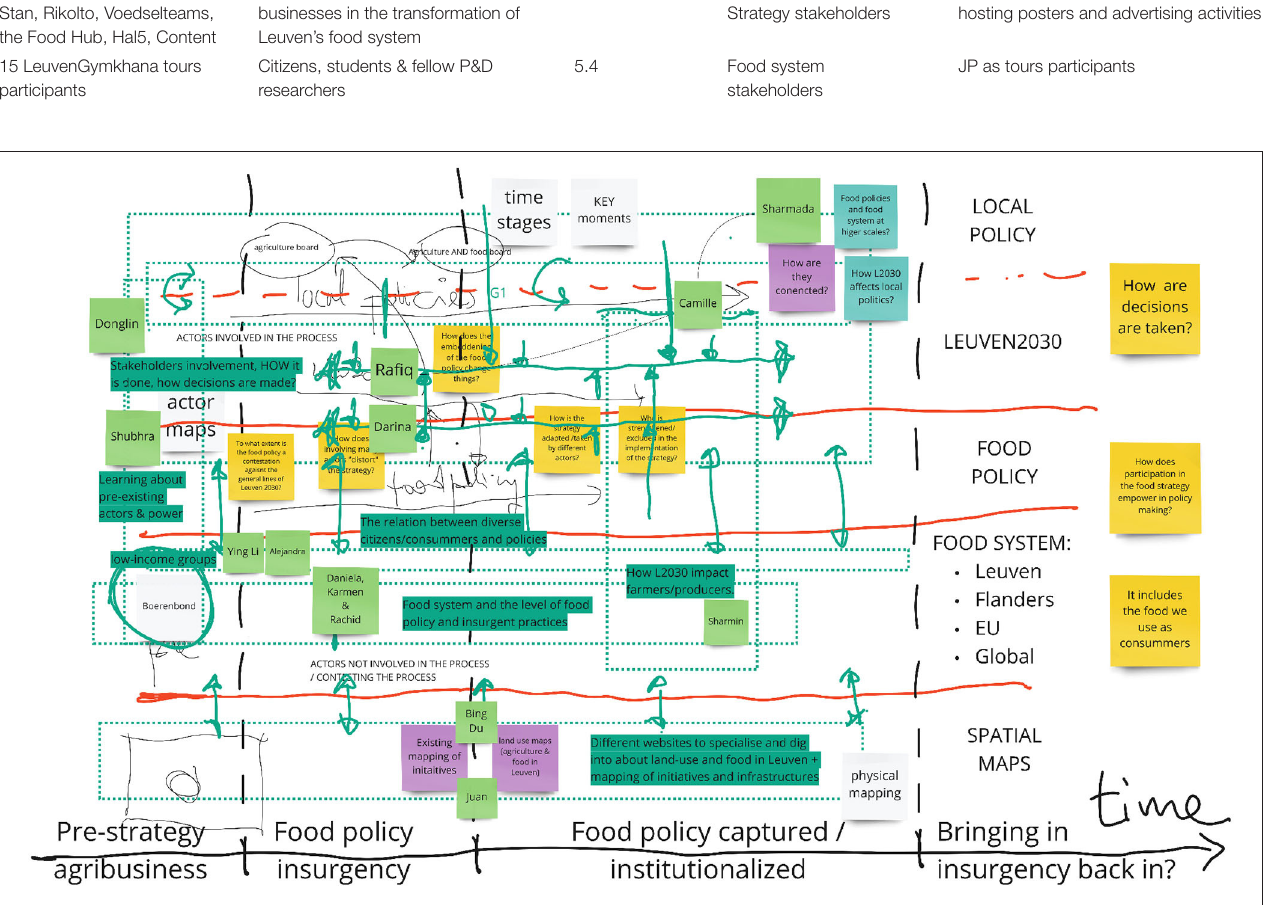
FIGURE 2 | Screenshot from the IASP Miro board scheme “building a narrative”.